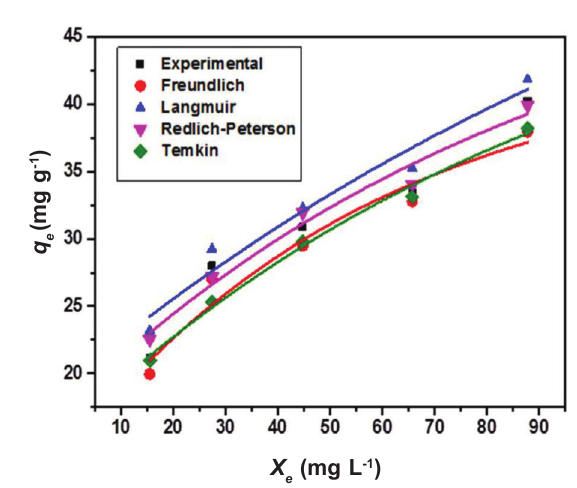
Fig. 7 – Adsorption equilibrium plot for 2-CP-RSAC adsorp- tion system (X = 50–150 mg L –1 ; t = 125 min; w = o 1.25 g L –1 ; pH = 8; T =303